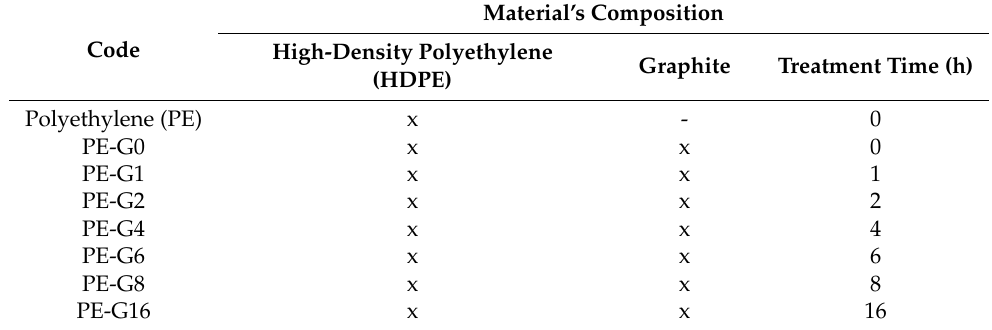
Table 1. Material’s code and